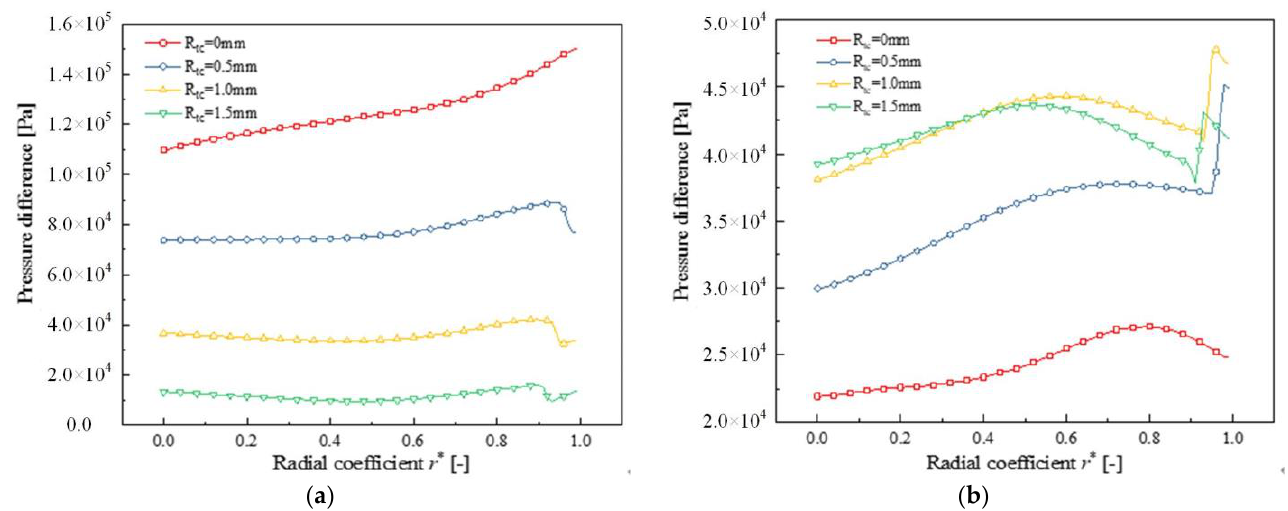
Figure 9. Impeller pressurization performance. ( a ) Radial pressurization performance from impeller inlet to middle ( b ) Radial pressurization performance from impeller middle to outlet.